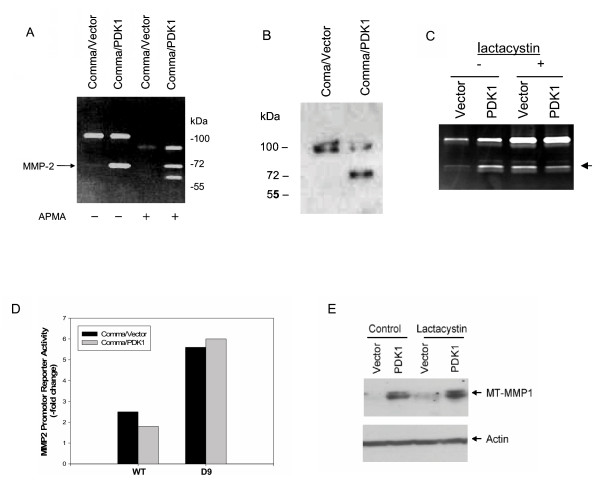
Overexpression of PDK1 increases MMP-2 activity and MT1-MMP. A, Comma/Vector and Comma/PDK1 cells were grown and conditioned medium was concentrated and assayed for MMP activity by zymography in the present or absence of 1 mM APMA as described in Methods. Protein markers are indicated by their mass in kDa. B, Concentrates of conditioned medium described in A containing 2 μg protein were separated under non-reducing conditions by SDS-PAGE in 10% polyacrylamide gels, and blotted onto nitrocellulose and analyzed with an anti-MMP-2 antibody. C, Comma/Vector (Vector) and Comma/PDK1 (PDK1) cells were incubated for 24 hr in the presence and absence of 1 μM lactacystin, followed by incubation in serum-free medium for 24 hr. Samples were assayed by zymography as in A. D, Cells were transfected with 'WT' or 'D9' MMP-2 promoter plasmids as described in Methods. Luciferase activity was measured after 24 hr and is expressed as the -fold change relative to control cells. Luciferase activity (light units) in control cells with the 'WT' and 'D9' plasmids was 2,970 and 6,520, respectively. E, Comma/Vector (Vector) and Comma/PDK1 (PDK1) cells were treated with or without lactacystin as in B and cell lysates analyzed by western blotting for levels of MT1-MMP.